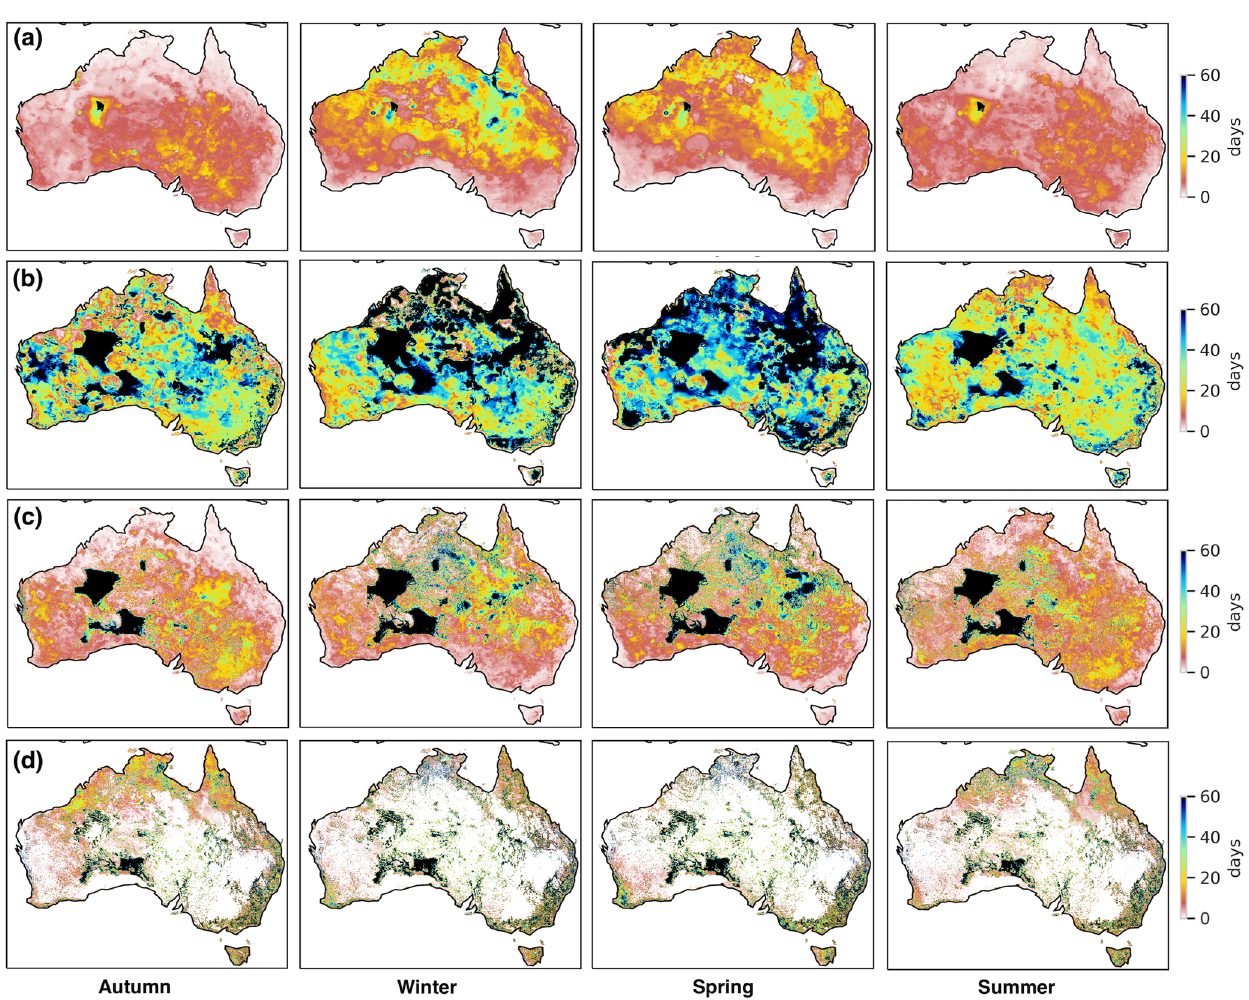
Figure 10. Quantified impacts of data assimilation on forecasting AWRA-L state variables using the initial condition from DA-TCAIR: average time period that the impact of data assimilation can persist in autumn (March–May 2018), winter (June–August 2018), spring (September–November 2018) and summer (December 2018–February 2019) on (a) upper layer soil water storage S 0 , (b) lower layer soil water storage S s , (c) total evapotranspiration E tot and (d) total runoff Q tot .